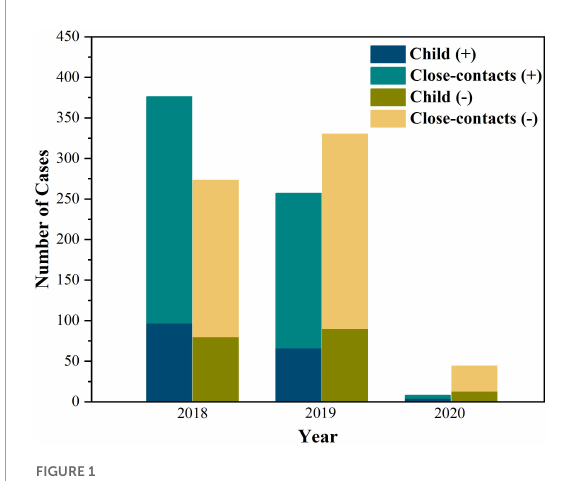
FIGURE1 The yearly distribution of children and close contacts between 2018 and